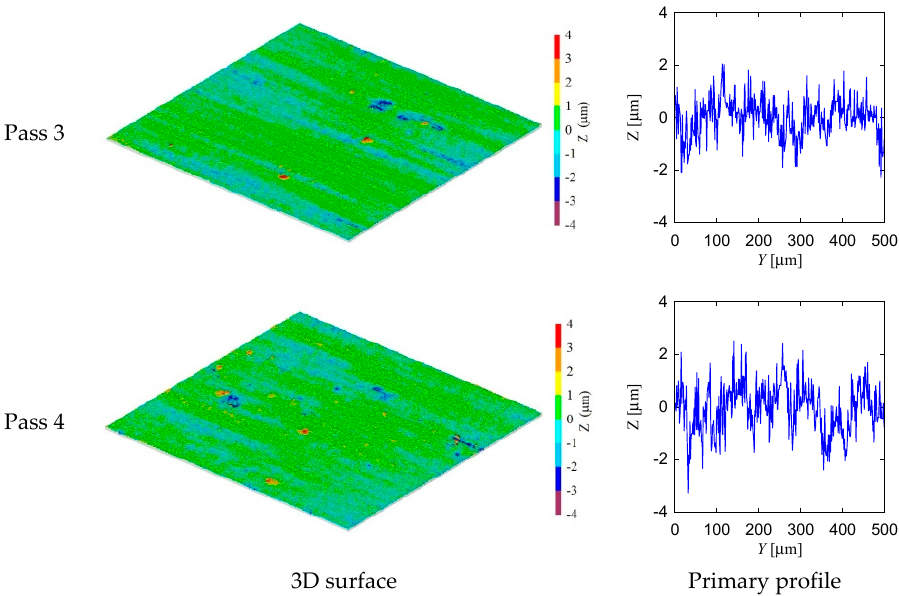
Figure 11. Surface topography of ground surface for feed rate V w = 40 mm/s.